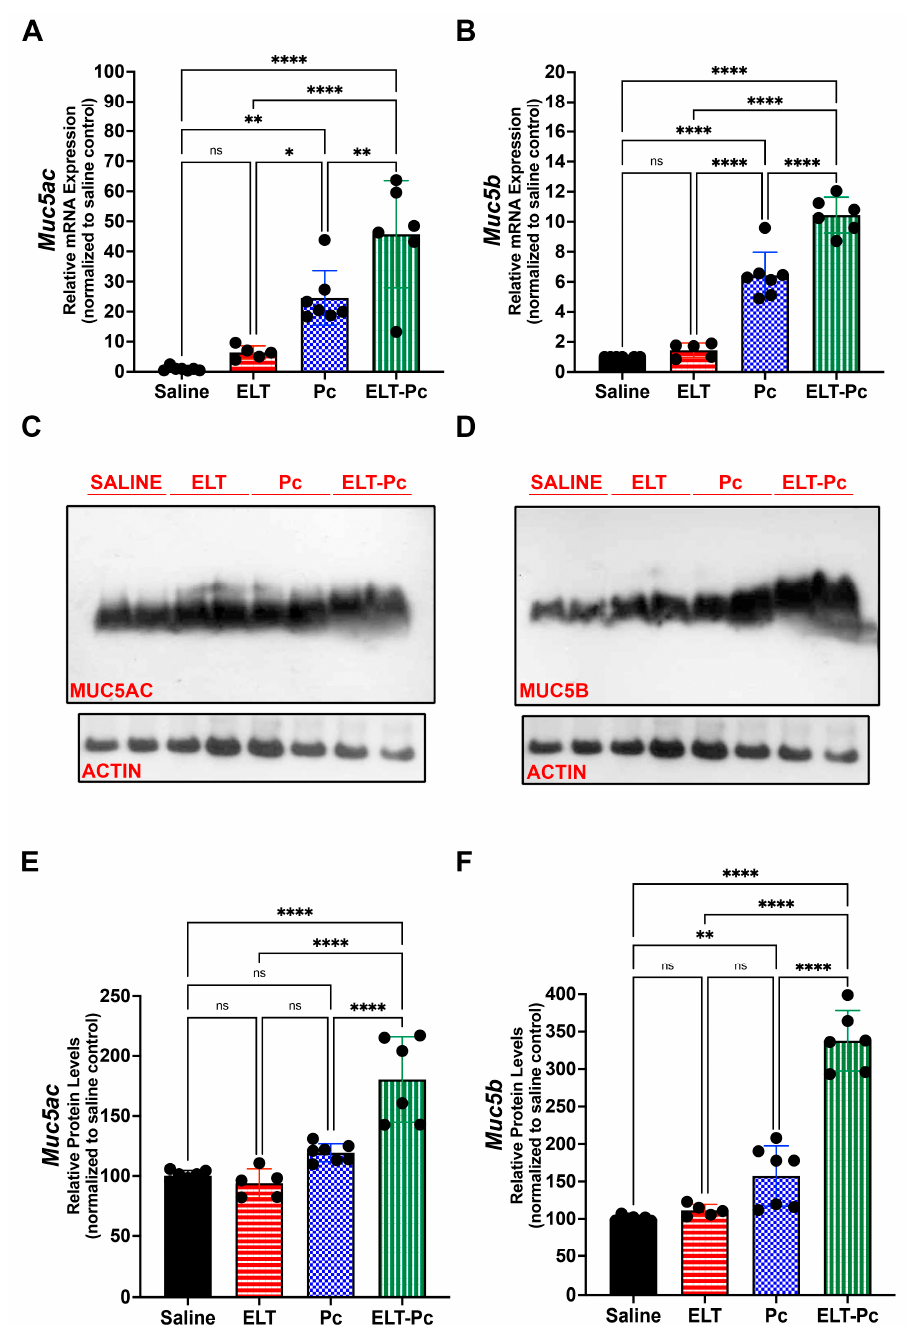
Figure 5. Evaluation of the mucin levels in the elastase-induced COPD animal model infected with Pneumocystis . mRNA levels of ( A ) Muc5ac and ( B ) Muc5b were evaluated by qPCR. Data were determined using the 2 − DDCt , actin levels as internal control and normalized to saline control animal group. Data are expressed as mean ± SD and analyzed by ANOVA. ns = nonsignificant; * = p < 0.05; ** = p < 0.01; **** = p < 0.0001. Protein levels of the mucins were evaluated by western blot. Representative images of western blot to evaluate ( C ) Muc5ac and ( D ) Muc5b are indicated in the figure. Actin was used as internal control. Quantification of ( E ) Muc5ac and ( F ) Muc5b are indicated. Data are expressed as mean ± SD and analyzed by ANOVA. ns = nonsignificant; ** = p < 0.01; **** = p <